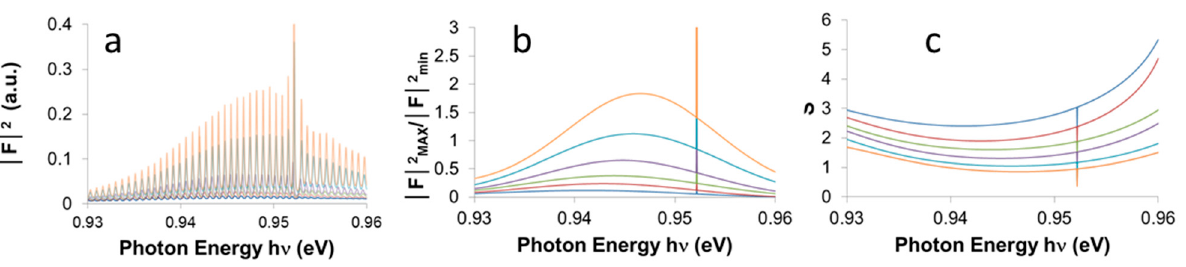
Figure 8. ( a ) Six spectra acquired from the same device as in Figure 3 in the sub-threshold region at different currents; ( b ) the ratios between maxima and minima for each spectrum; ( c ) the corresponding S functions (Equation (23)) according to the Hakki–Paoli method.